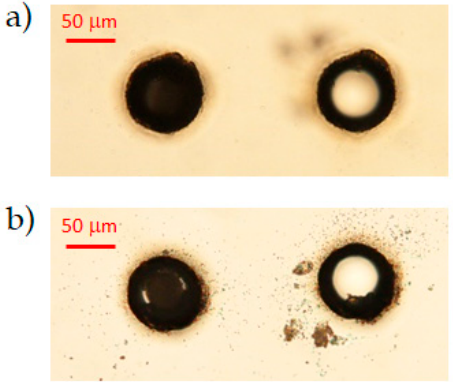
Figure 4. Optical microscope images of holes (( a ) top surface, and ( b ) bottom surface) performed with 40 (left images) and 41 (right images) number of writing circles in the single pass BB micro-drilling process on a 200 µ m thick AF32 glass sample (pulse energy 118 µ J).